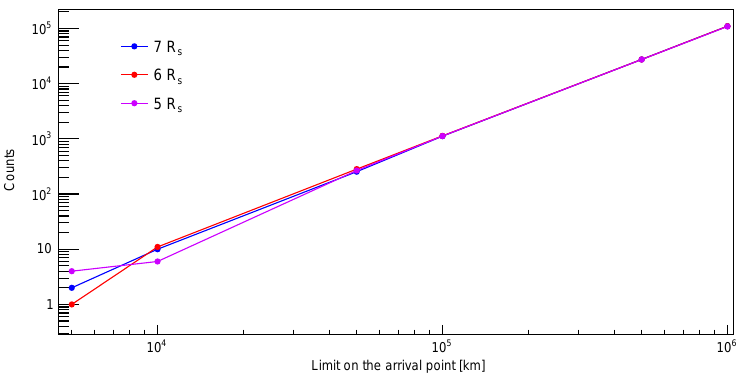
Figure 5. The graph of the number of simulations that fulfilled the arrival point limit in 10 10 simulations, executed for each limit, as a function of the arrival point limit, for different starting sphere radiuses: 5 R (cid:12) , 6 R (cid:12) , and 7 R (cid:12) .